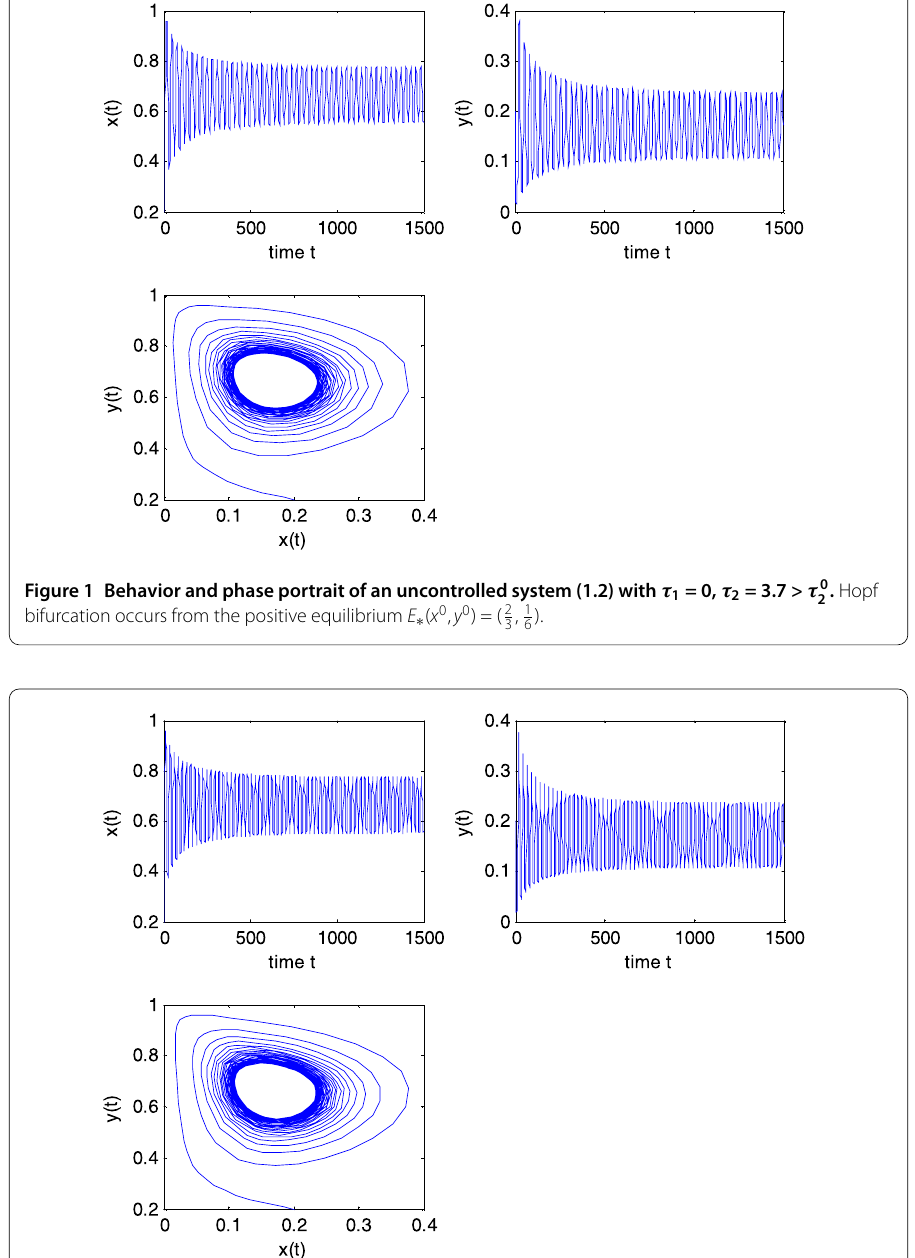
Figure 2 Behavior and phase portrait of an uncontrolled system (1.2) with τ 1 = 0.8 > τ 0 bifurcation occurs from the positive equilibrium E ∗ ( x 0 , y 0 ) = ( 2